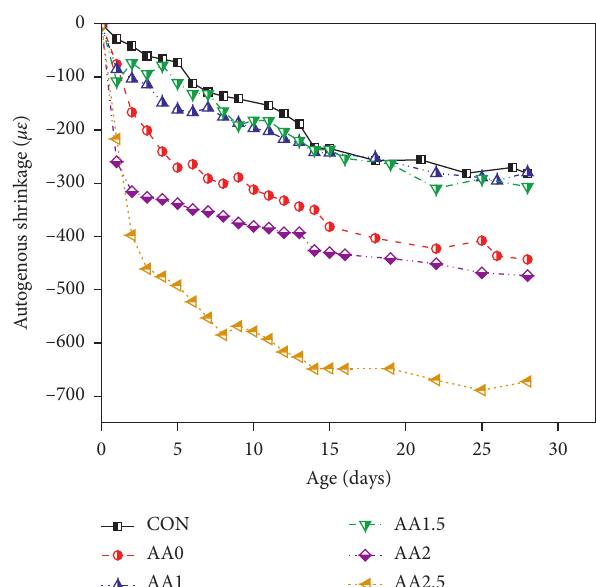
Figure 3: Autogenous shrinkage curve of the test